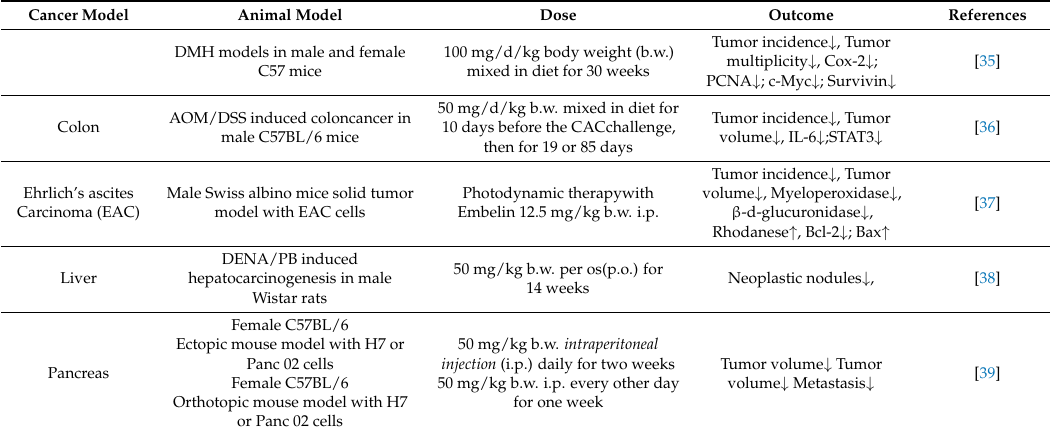
Table 1. In vivo anti-cancer effects of embelin.